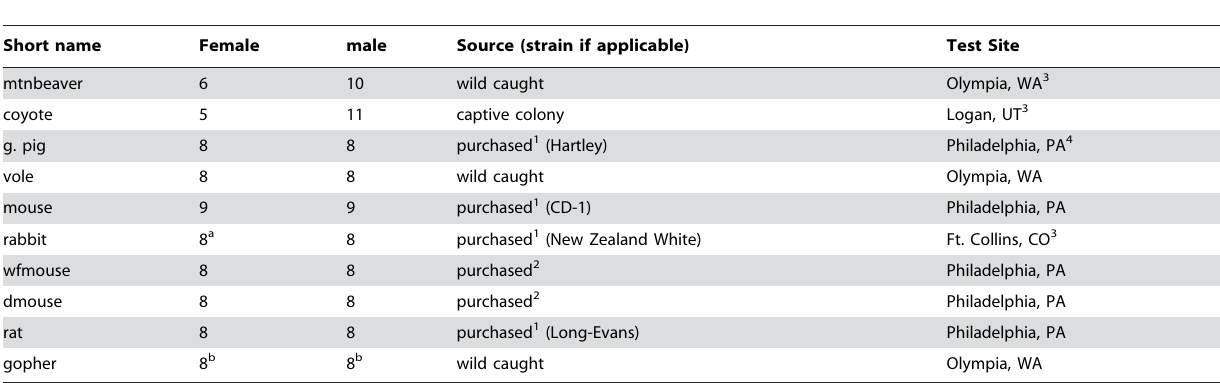
Table 2. Sample sizes by sex, sources and test sites for species used in preference